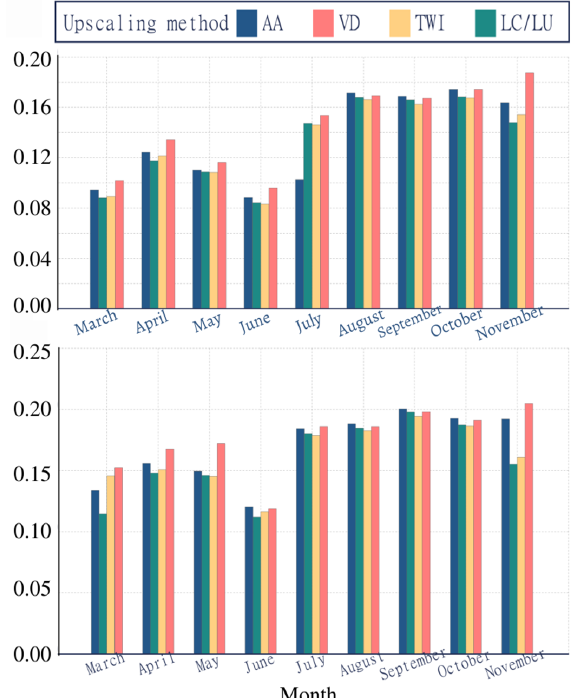
Figure 7. Temporal variation of monthly MD values (in m 3 .m − 3 ) for SMAP L2SMP_E AM overpass ( top ) and PM overpass ( bottom ) observations and in situ measurements derived from the upscaling techniques based on the Arithmetic Average (AA), Voronoi Diagram (VD), Topographic Wetness Index (T), and Land Cover (LC).